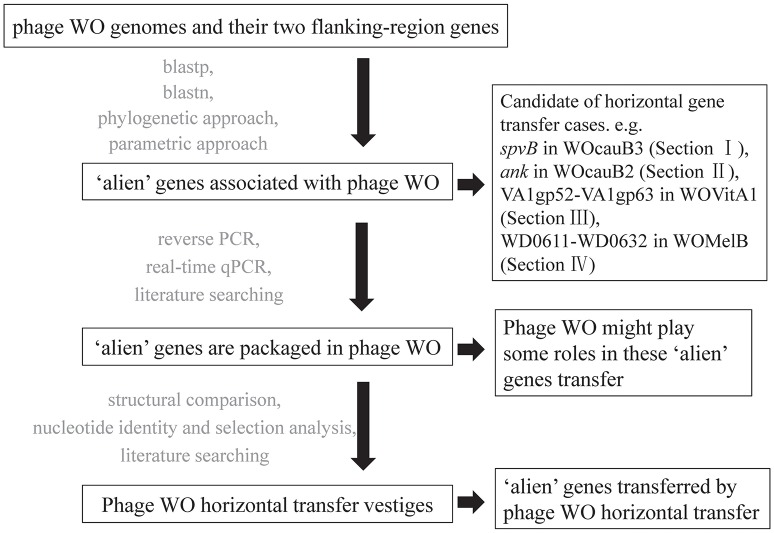
Flow chart of the screening methods and the results of each step used to detect phage WO mediating horizontally transferred genes.